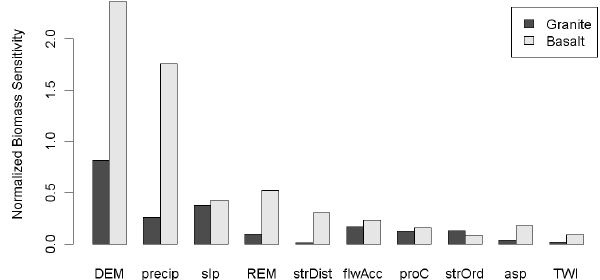
Fig. 5. Biomass sensitivity to landscape factors: a simple one-at-a- time (OAT) screening to observe the first-order, additive response of AGB to an initial set of landscape factors. Factors shown are DEM=ground elevetation above sea level, precip=precipitation, slp=slope, REM=Relative Elevation Model (height above near- est stream), strDist=distance to nearest stream, flwAcc=stream flow accumulation, proC=profile convexity, strOrder=stream Or- der, asp=aspect, TWI=topographic wetness